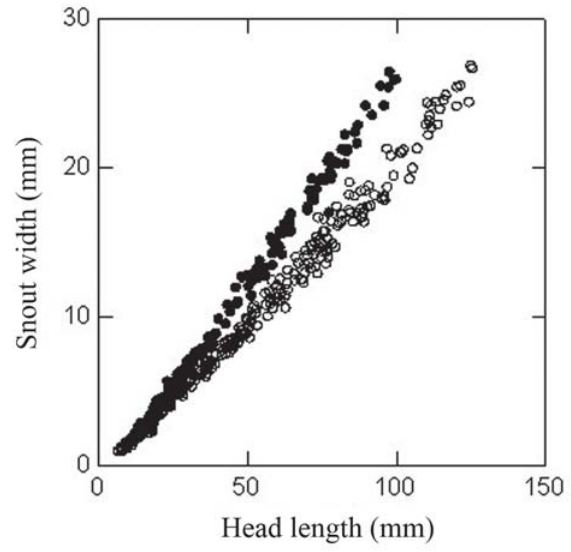
Fig. 6. Snout width vs . head length for Hoplias curupira (dots) and remaining species of the Hoplias lacerdae group (circles).